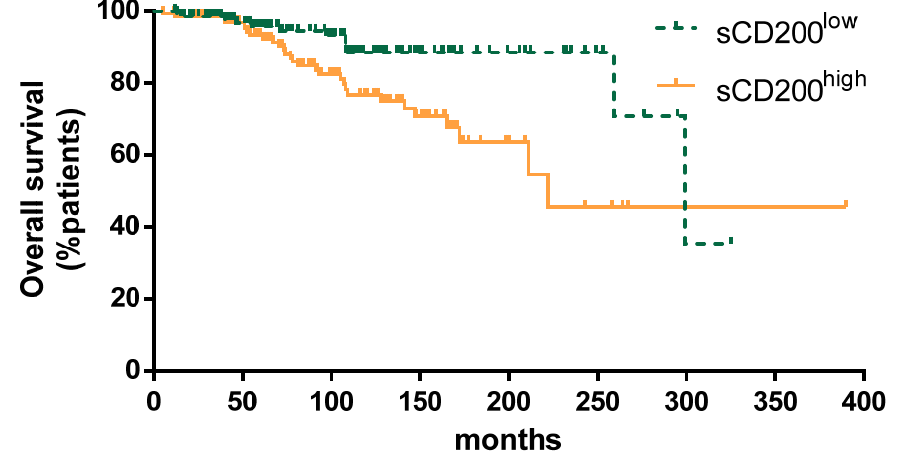
Figure 3. Overall survival for patients with sCD200 low vs. sCD200 high .